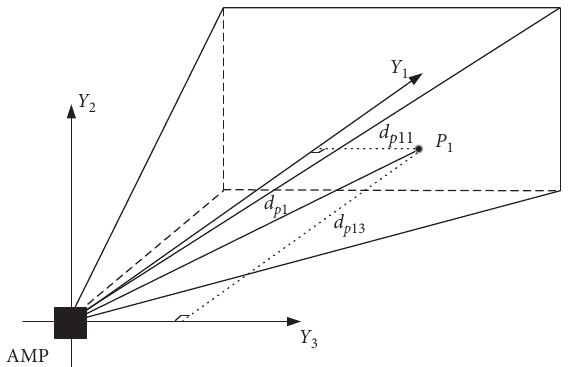
Figure 1: Illustration of CVS scanning the environment as a 3D lidar: OY 1 — AN R longitudinal axis; P Y 2 — AN R transverse axis; P 1 —obstacle point; d p 11 and d p 12 —lengths of perpendiculars from the obstacle to the axes P Y 1 and P Y 3 ; d p 1 —distance to the point R 1